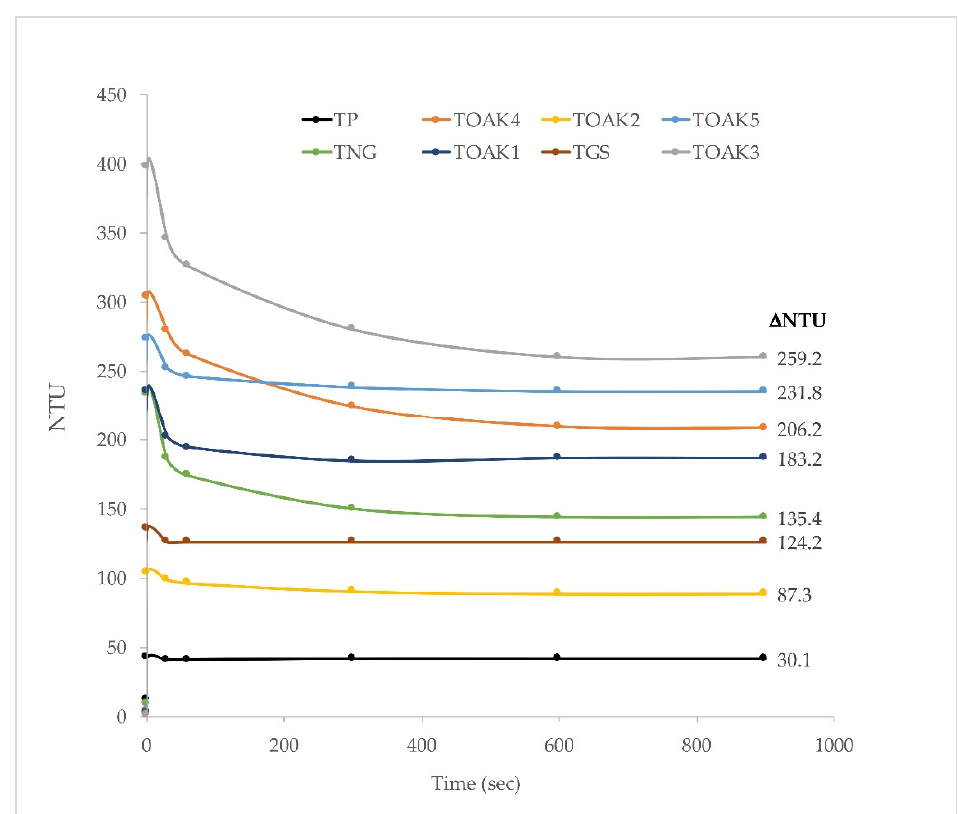
Figure 3. Reaction kinetics of the analyzed tannins dissolved in the model wine solution with gelatin from bovine serum albumin, and Δ NTU (nephelometric turbidity unit). Pomegranate tannin; TGS, grape seed tannin; TNG, Nut gall tannin; TOAK1, TOAK2, TOAK3, TOAK4, TOAK5, Oak tannin 1–5, respectively.